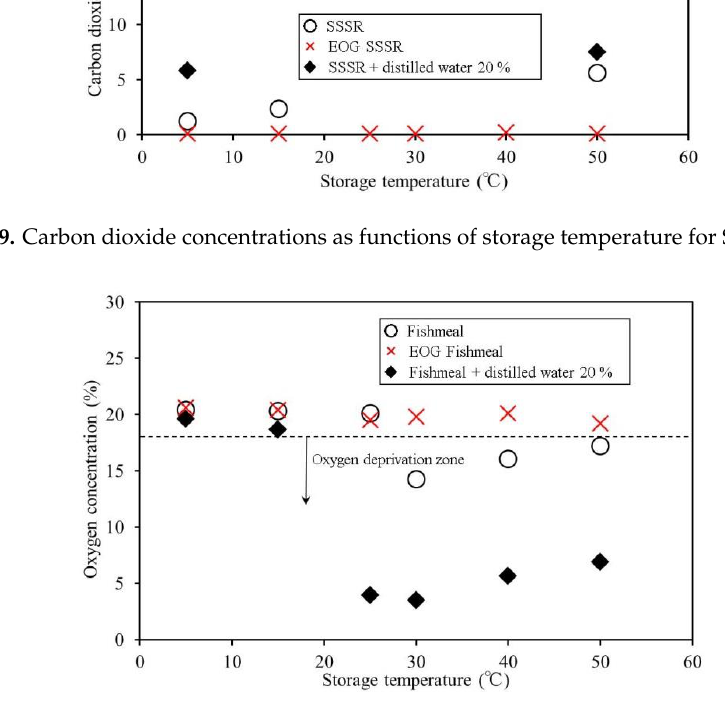
Figure 20. Oxygen concentrations as functions of storage temperature for fishmeal samples.